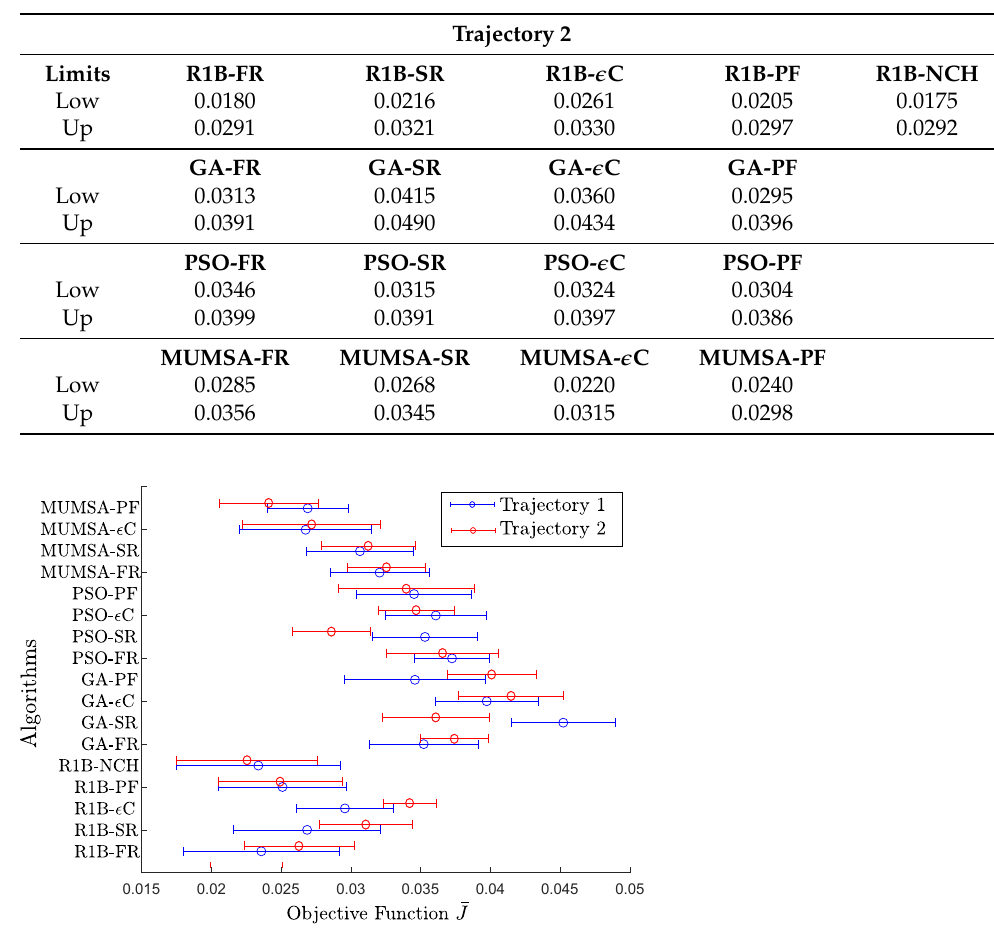
Figure 7. Graphical representation of confidence intervals for algorithms solving the study case 1 in both